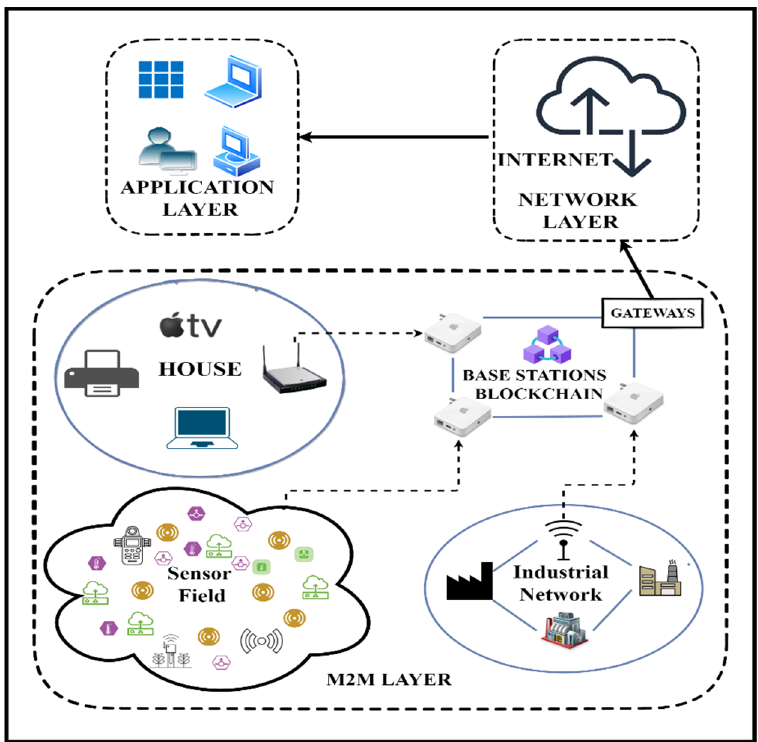
Figure 2. Architecture of M2M Layer .